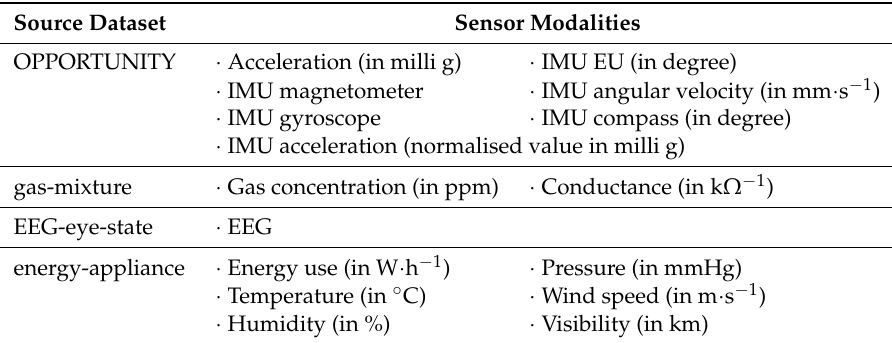
Table 1. List of sensor modalities in the source domain using the OPPORTUNITY, gas-mixture, EEG-Eye-State and energy-appliance datatsets (obtained from the documentation of each respective dataset). The respective units of measurement are provided in parenthesis when the information was